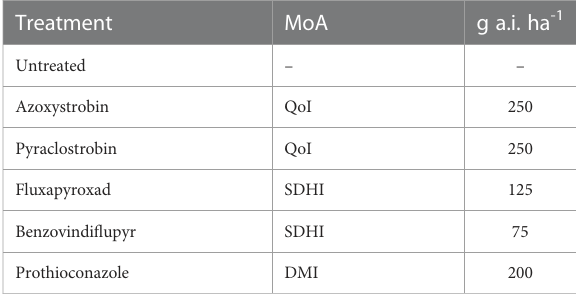
TABLE 1 Fungicide treatments (active ingredients g ha -1 ) applied in the fi eld trials at GS 39.